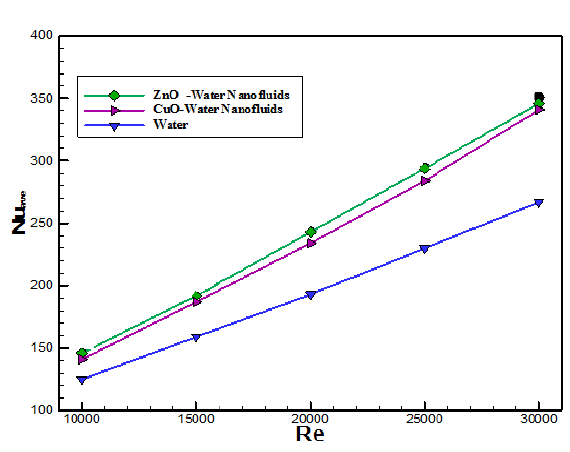
Fig. 7. Variation of average Nusselt number for pure water and different nanofluids types with trapezoidal ribs.